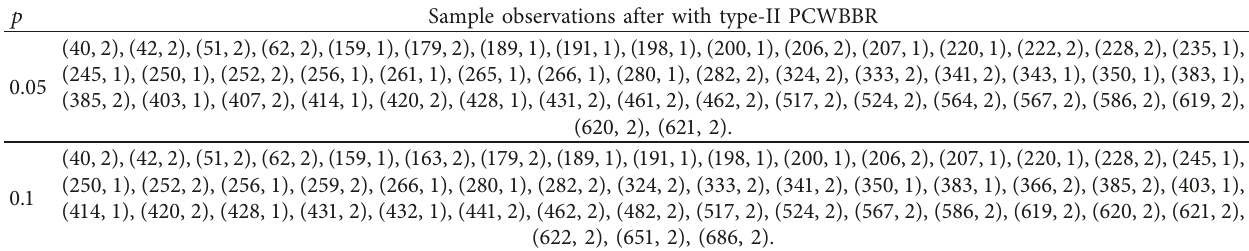
Table 19: The survival times of mice exposed to a fixed dose of radiation.